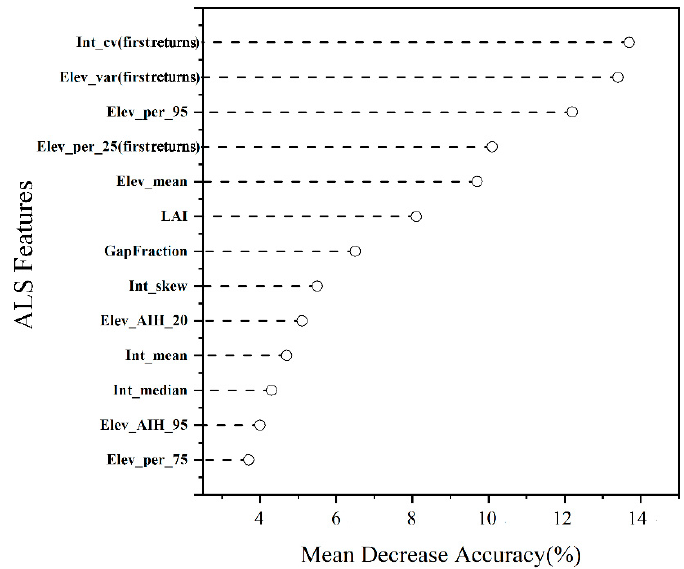
Figure 5. The MDA ranking of feature variables from ALS data. Note: Int_cv(first returns)—coeffi-